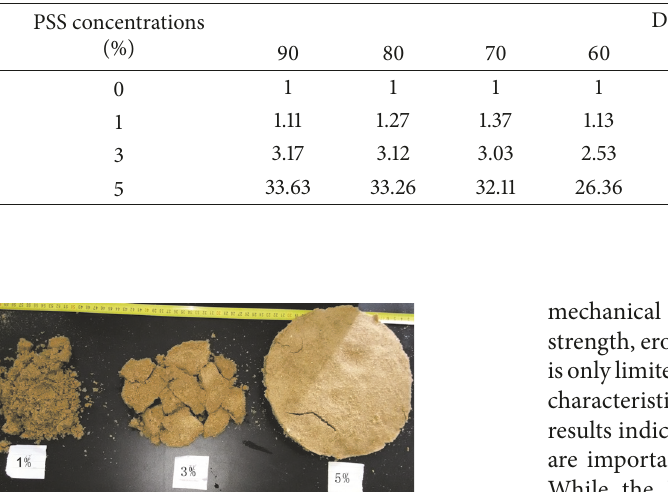
Table 7: The relative permeability resistance of specimens with different depth.